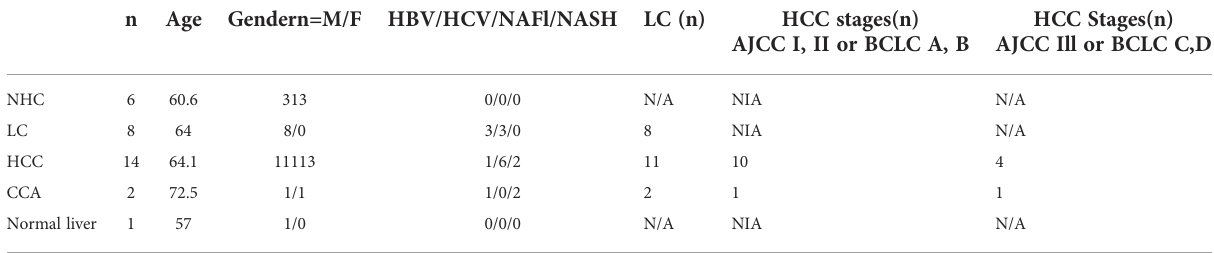
TABLE 1 Clinical and demographic information of patients used as a source of plasma and tumor tissues for RNAseq